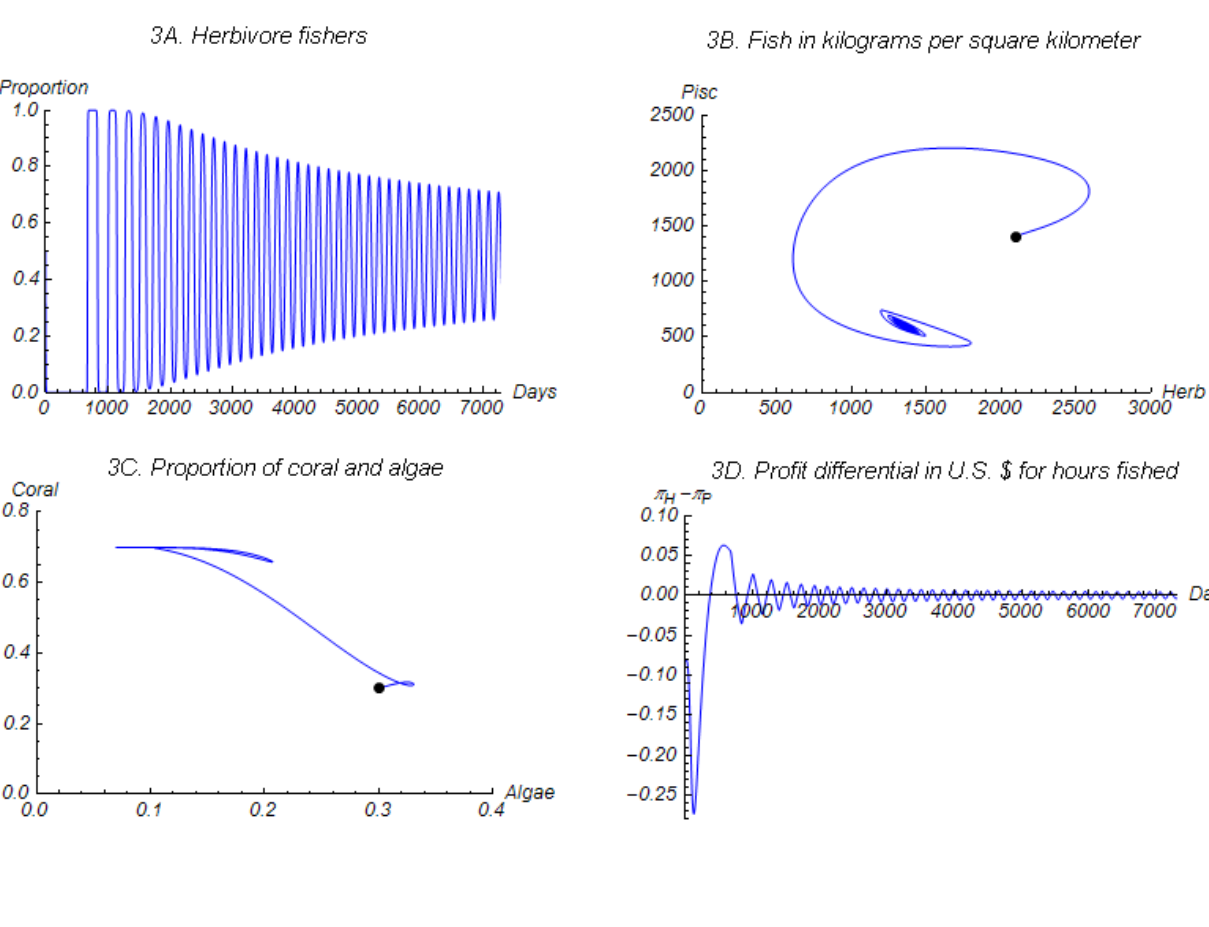
Fig. 3 . Baseline simulation time-series plots for fisher populations (3A) and profit differentials (3D), and parametric plots for fish (3B) and for coral and algae (3C). The dots represent initial